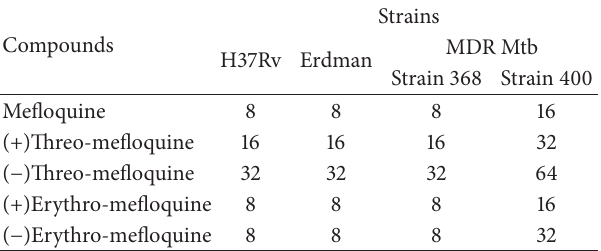
Table 2: Activity of mefloquine, (+)erythro-mefloquine, and ( − )erythro-mefloquine against H37Rv, Erdman and MDR-TB strains in oxygen-depleted environment (NRB) in vitro (Wayne model).